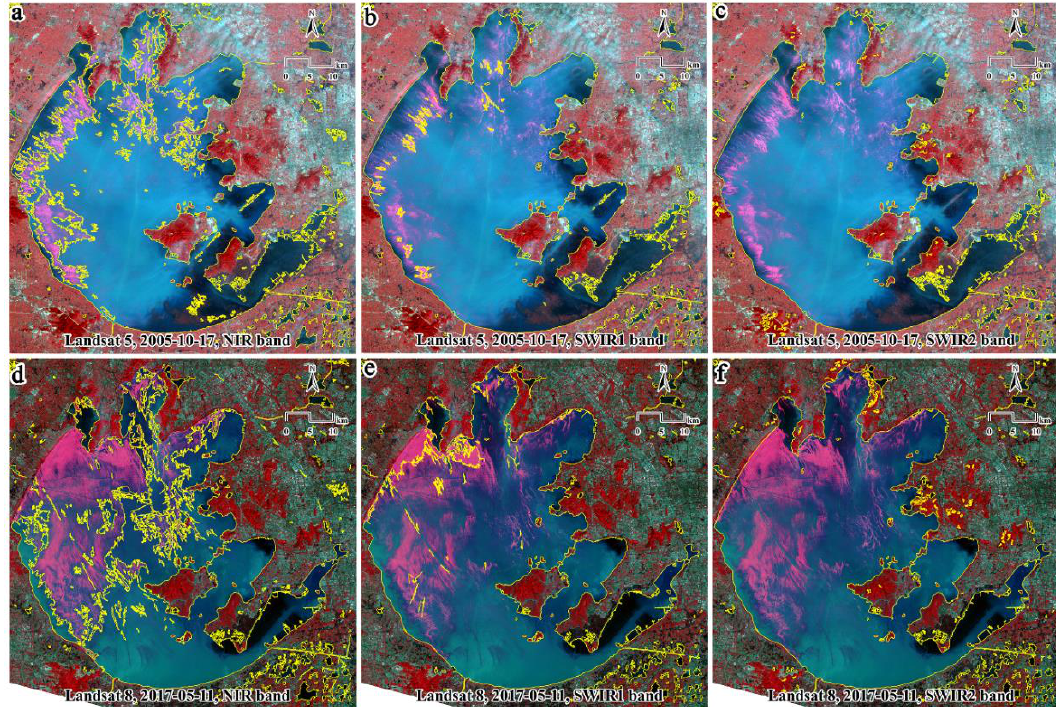
Figure 5. Sample water extraction results for water bloom effected water bodies (the yellow line is the extracted water boundary, and the background image is with standard false color composition).